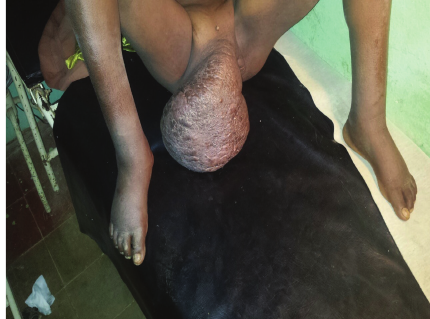
Figure3:Patient“B”oninitialpresentation.Giantcondylomanoted to be growing off right aspect of vulva with extension to the mons pubis.